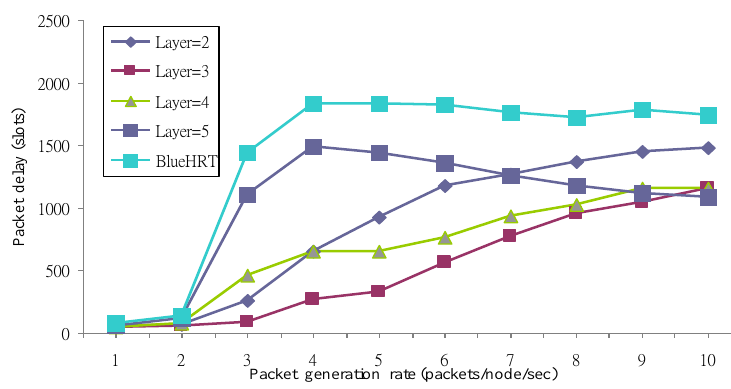
Figure 12. Average packet delay of mesh-tree and BlueHRT.